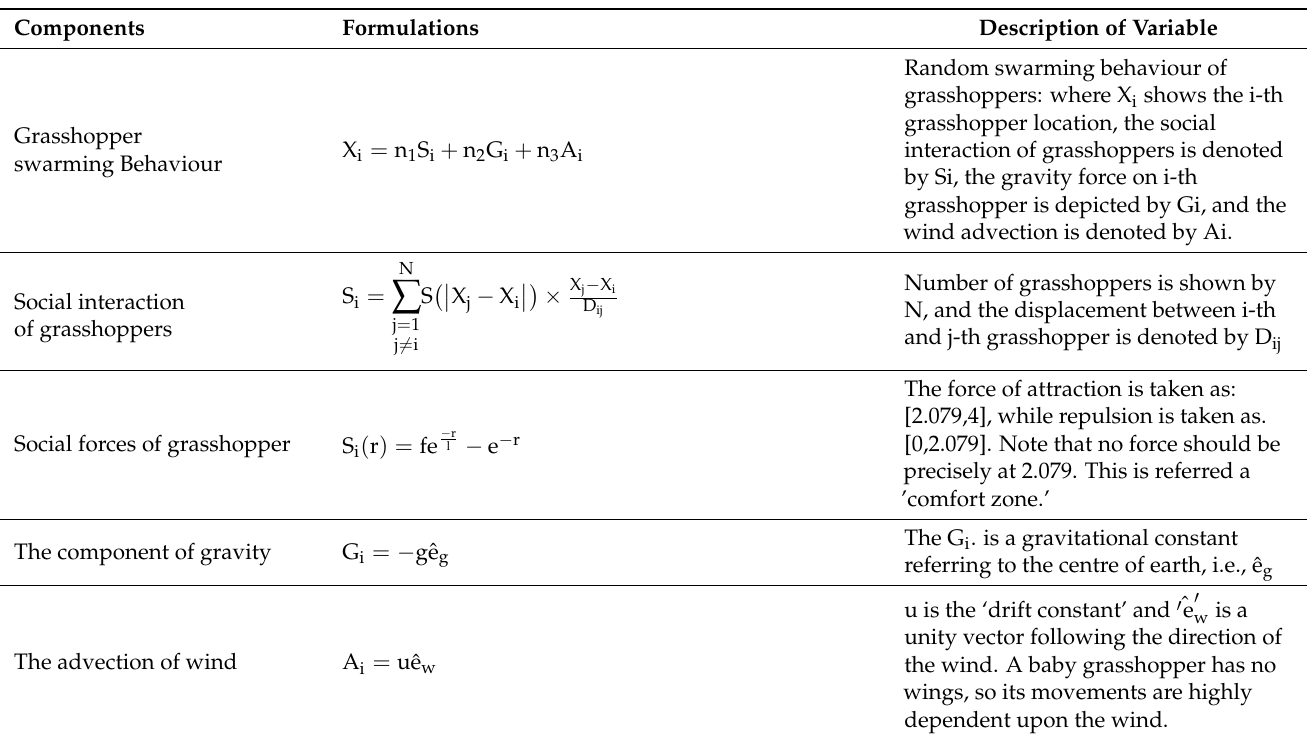
Table 4. Grasshopper Optimization